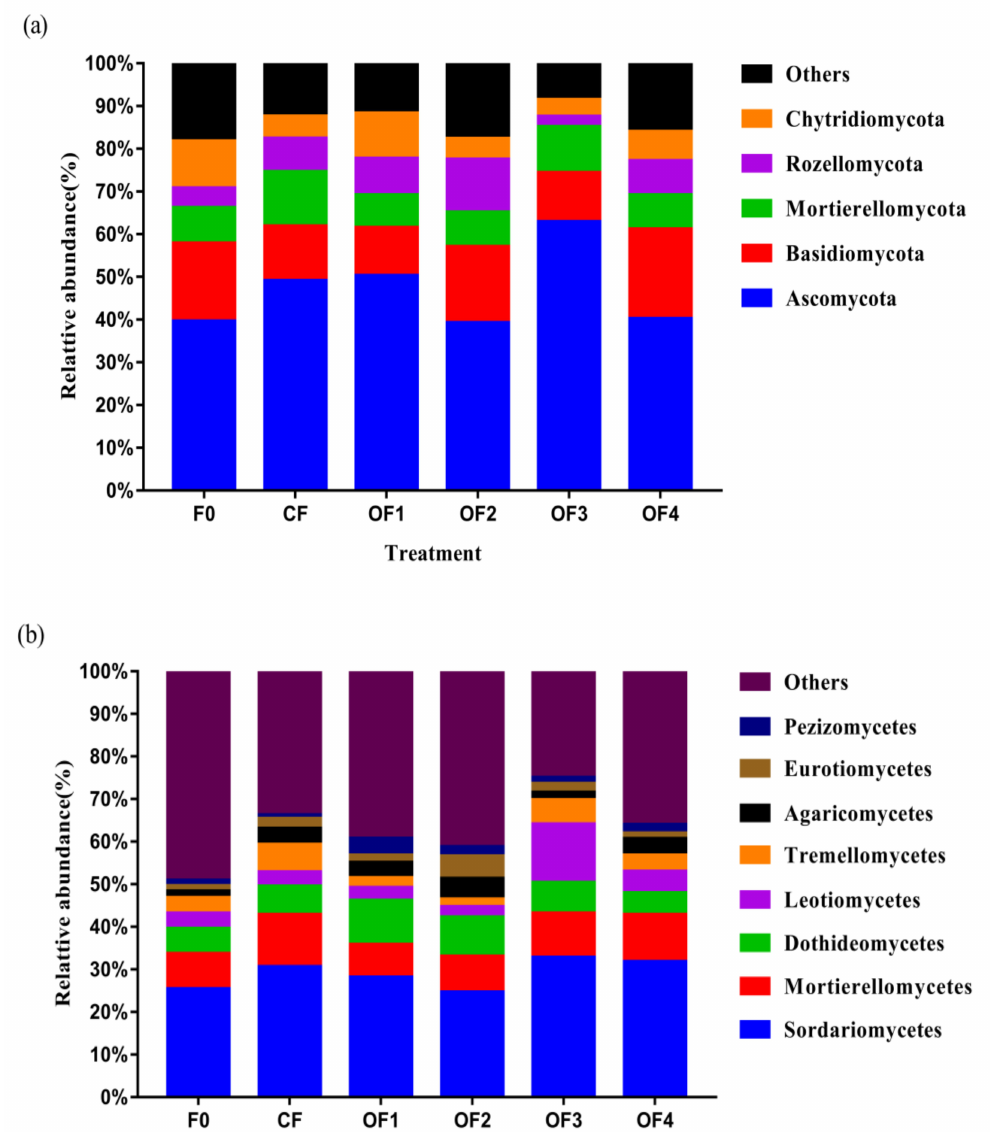
Figure 5. Dominant fungal phyla ( a ) and classes ( b ). F0, no fertilizer (F0); CF, conventional NPK fer- tilizer, OF1, biochar + conventional NPK fertilizer; OF2, seaweed bioorganic fertilizer + conventional NPK fertilizer; OF3, Jishiwang bioorganic fertilizer + conventional NPK fertilizer, OF4, attapulgite organic fertilizer + conventional NPK